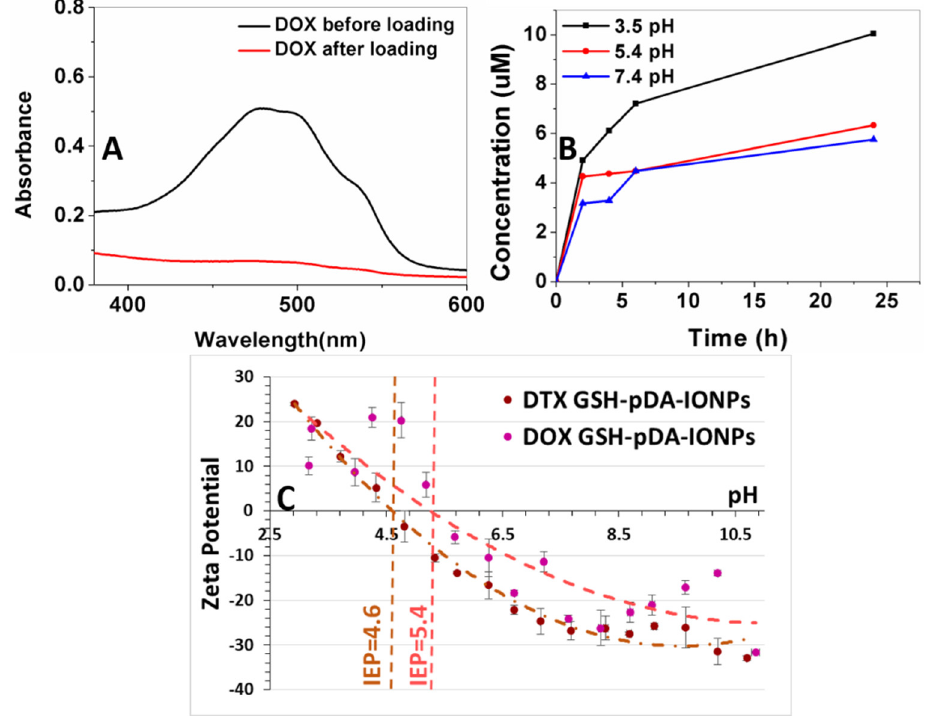
Figure 7. UV-vis absorbance spectra showing ( A ) doxorubicin loading on GSH-pDA-IONPs; ( B ) doxorubicin release at different pH in PBS (10 mM); and ( C ) zeta potential vs. pH curves of DOX- and DTX-drug loaded nanoparticles.